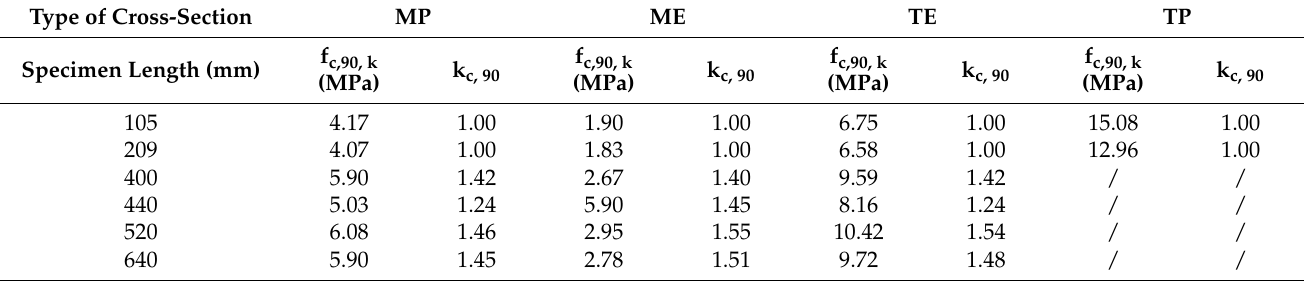
Figure 11. FE verification: ( a ) MP-209 mm; ( b ) ME-209 mm. Table 3. List of CSPGs for different load modes and boundary conditions with associated k c,90 factors.